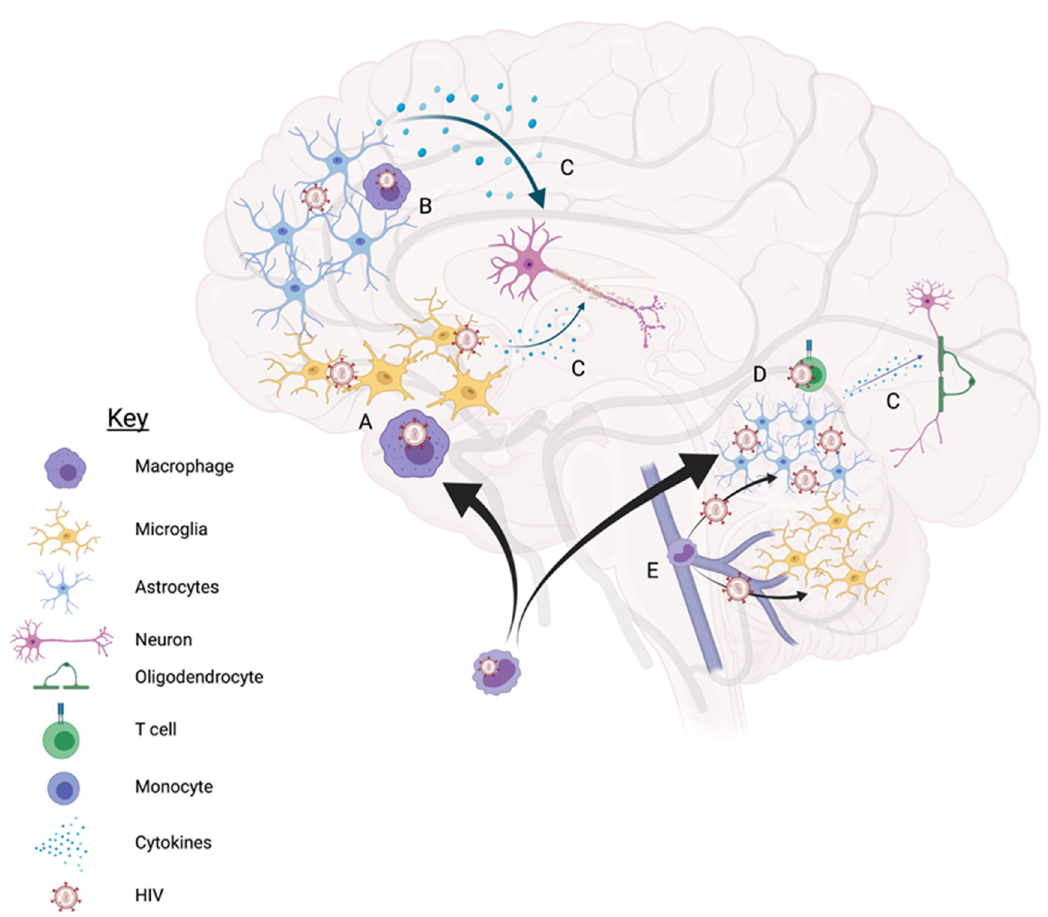
Figure 1. Depiction of cells in the brain and their interactions with HIV. ( A ) HIV+ macrophages (purple) circulate through the blood brain barrier and pass through into the CNS, where they can release viral particles and infect microglia (yellow). ( B ) direct contact with infected macrophages infects astrocytes (orange), which have the capability to pass viral infection to other astrocytes. Anti-HIV responses by astrocytes are much more potent in the cortex than in the cerebellum, therefore leading to a greater number of HIV+ cells in the cerebellum than in the cortex. ( C ) HIV+ macrophages and microglia, as well as astrocytes stimulate a powerful inflammatory response against infection (red dots), leading to damage and death of neurons (pink) and oligodendrocytes (green). ( D ) Circulating infected CD4+ T cells are trafficked into the brain and can infect glial cells via direct contact. ( E ) theorized route of infection from the meningeal lymphatic system, where HIV+ monocytes (blue) stimulate inflammation to permeabilize the vessels and carry infection into the CNS independent of the blood brain barrier. Created with BioRender.com.